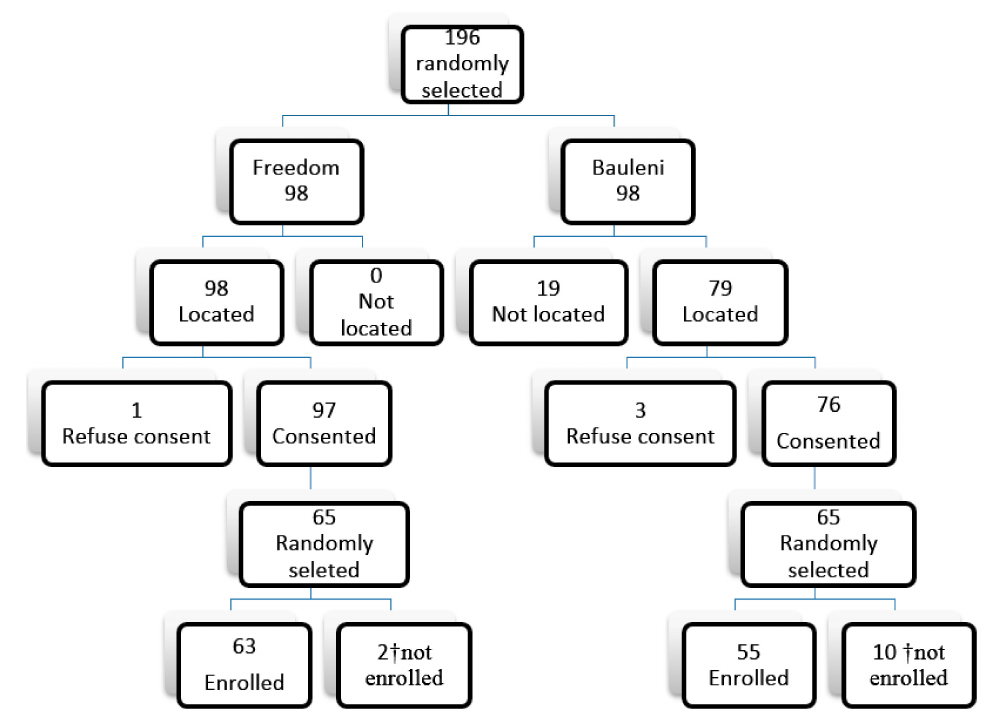
Figure 1. Schematic drawing of participant selection. † total of 12 were not enrolled; 4 changed residential place, 5 found employment outside study area consent and 3 withdrew